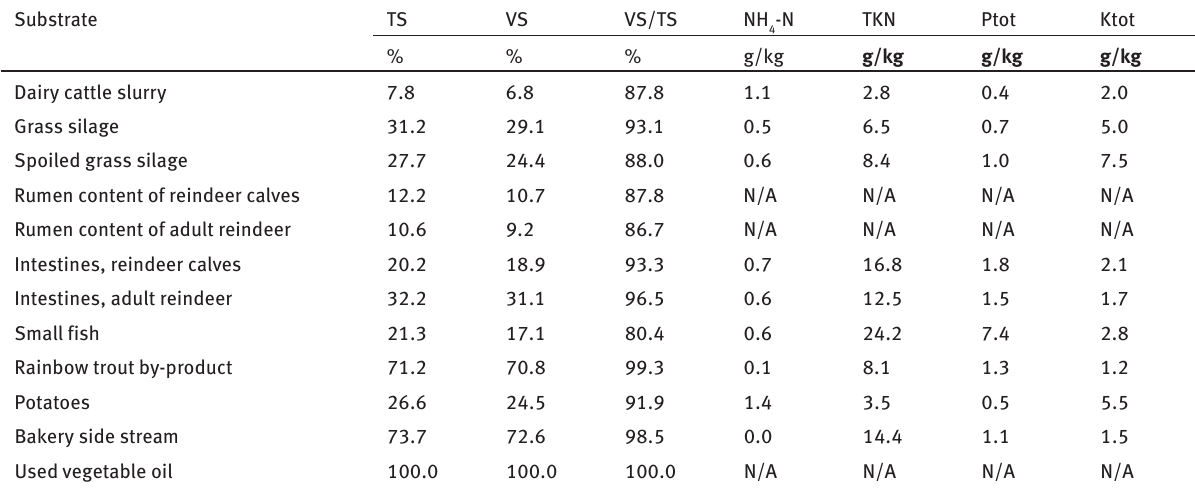
Table 2: Characteristics and main nutrient concentrations of the studied substrates Substrate